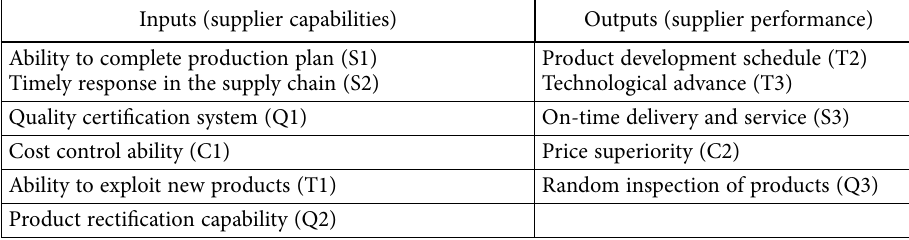
Table 3. Input and output criteria of suppliers for engine components Inputs (supplier capabilities) Outputs (supplier performance) After-sales claim in three months (Q3 *